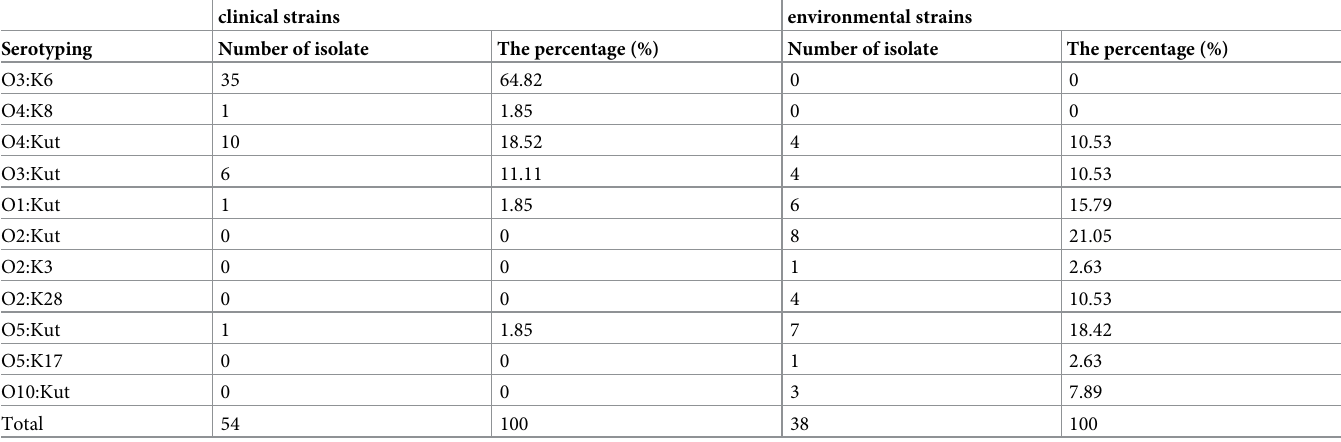
Table 1. Serotypes of 92 V . parahaemolyticus isolates from clinical and environmental samples in Huzhou. clinical strains